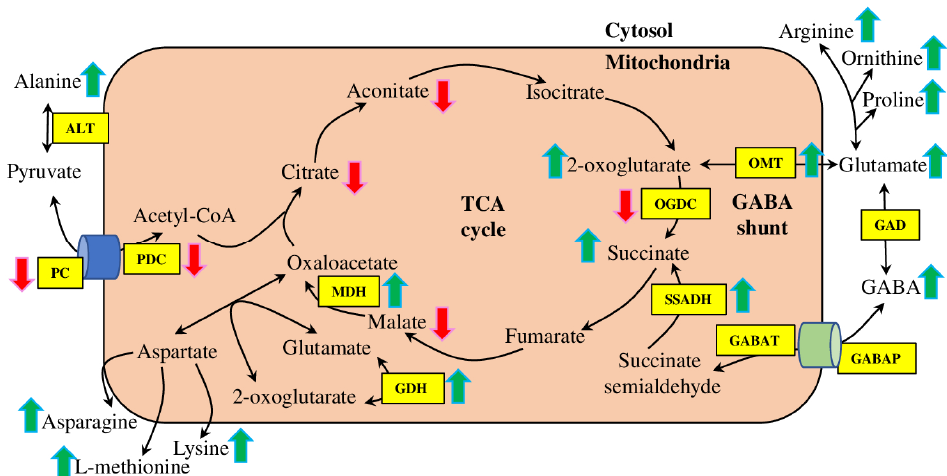
Figure 2. The effect of salt stress on TCA cycle and GABA shunt functioning. Salt stress impairs the pyruvate uptake by PC (pyruvate carrier) and PDC (pyruvate dehydrogenase), which leads to subsequent depletion of citrate and aconitate. Additionally, the level of OGDC (2-oxoglutarate dehydrogenase) decreases, thus decreasing 2-oxoglutarate conversion into succinate. However, the levels and activities of OMT (2-oxoglutarate dehydrogenase) and SSADH (succinate semialdehyde dehydrogenase) provide an alternative supply for the TCA cycle. In parallel, oxaloacetate and 2-oxoglutarate are used to produce surplus amounts of diverse amino acids. Abbreviations: GDH—glutamate dehydrogenase; MDH—malate dehydrogenase; ALT—alanine aminotransferase. Red arrows indicate decreased enzyme/metabolite activity/abundance, and green arrows indicate increased enzyme/metabolite activity/abundance.